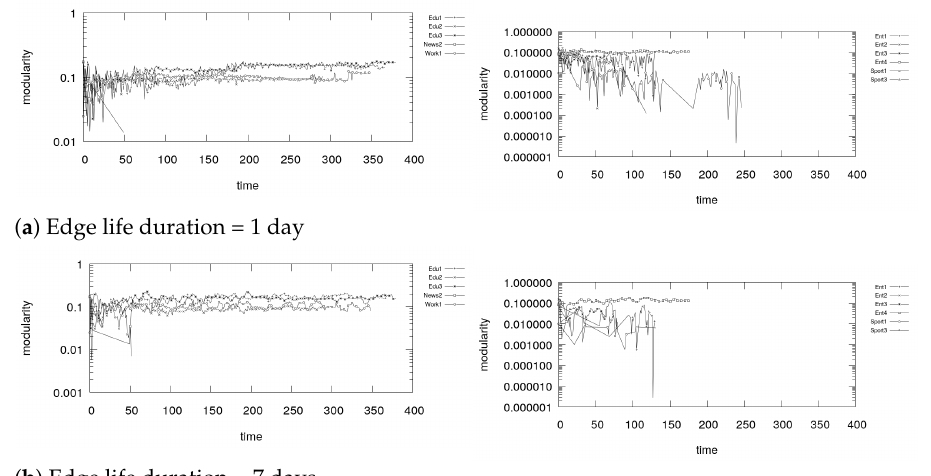
Figure 24. Modularity of communities detected by K-core.